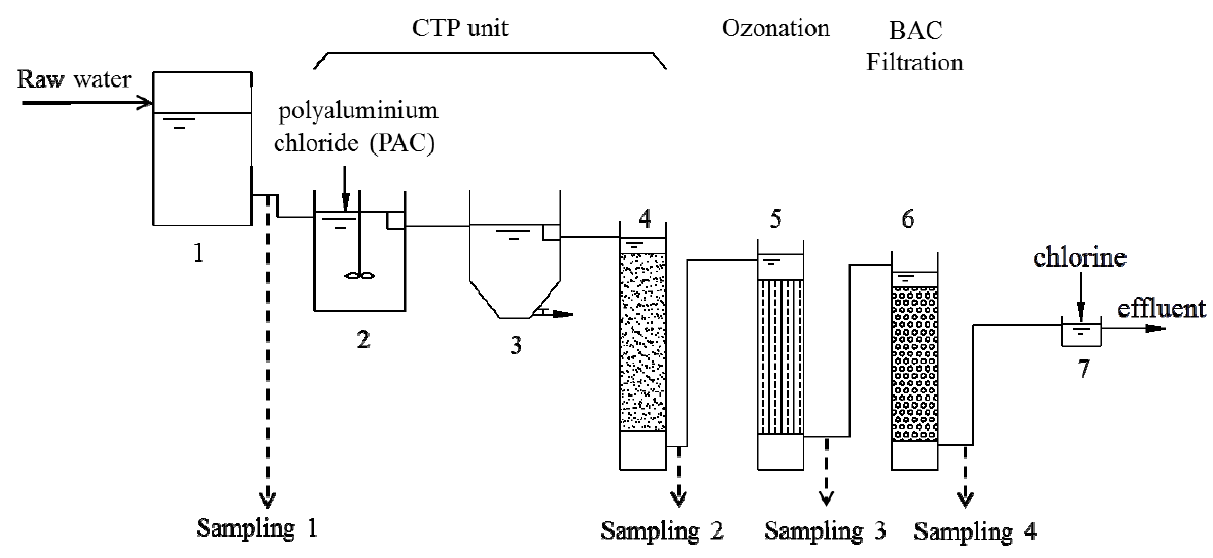
Figure 1. Flow chart of the pilot water treatment plant (the dotted arrows represent the sampling locations). 1: storage tank; 2: flocculation reactor; 3: sedimentation tank; 4: sand filter; 5: ozone contact reactor; 6: biologically activated carbon filtration (BAC); 7: disinfection reactor. (CTP: conventional treatment process).